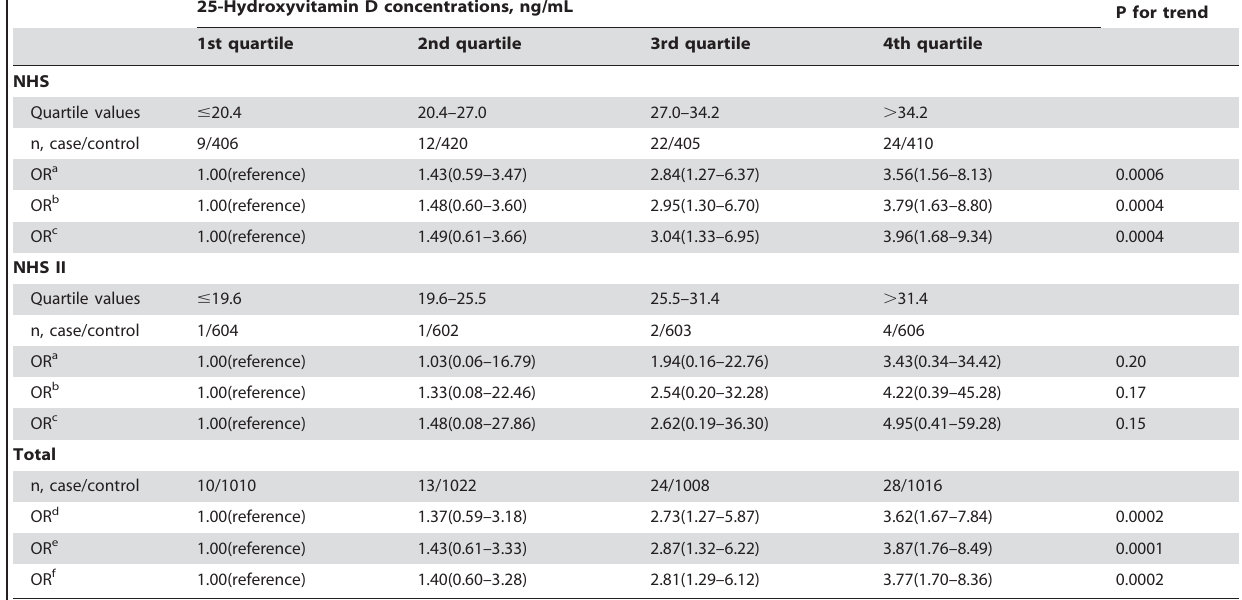
Table 3. Odds ratios of SCC by quartile of plasma vitamin D concentrations in NHS and NHS II.